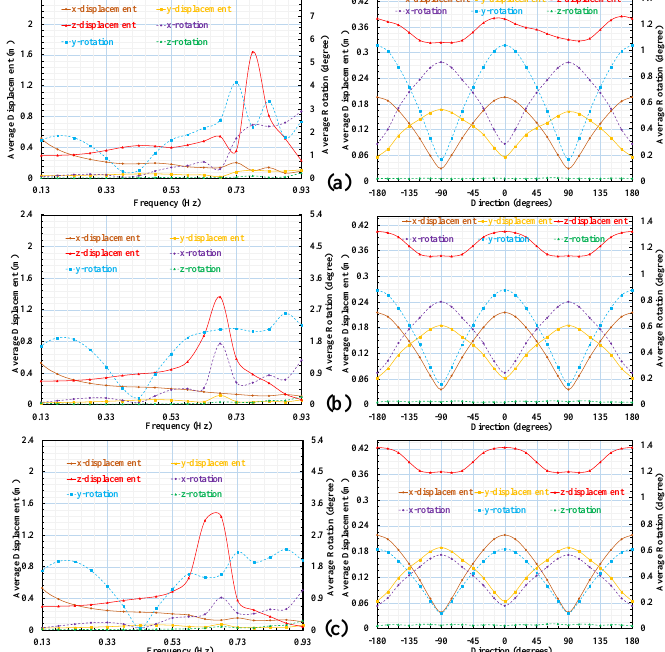
Figure 13. Average displacement and rotation of 18 modules with a variety of frequency ranges and directions, ( a ) 2.13 m 2 , ( b ) 2.33 m 2 , and ( c ) 2.43 m 2 of wetted surface area for each module.